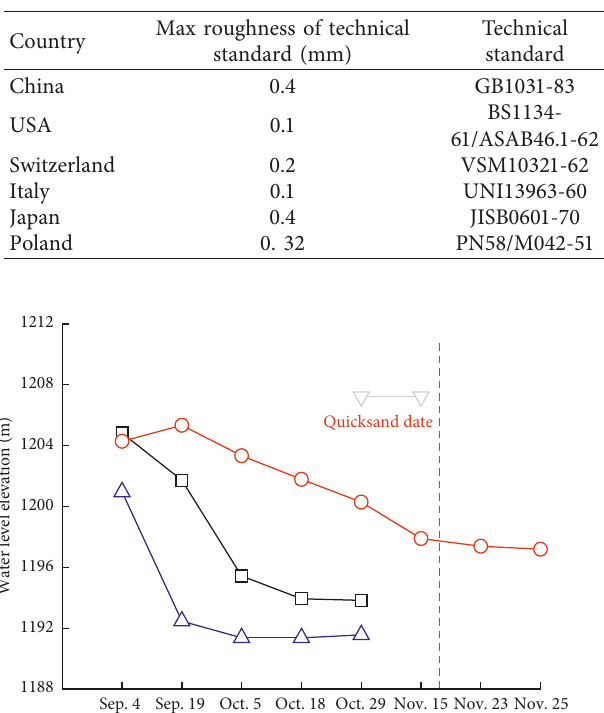
Table 6: Max roughness of technical standard in part country.